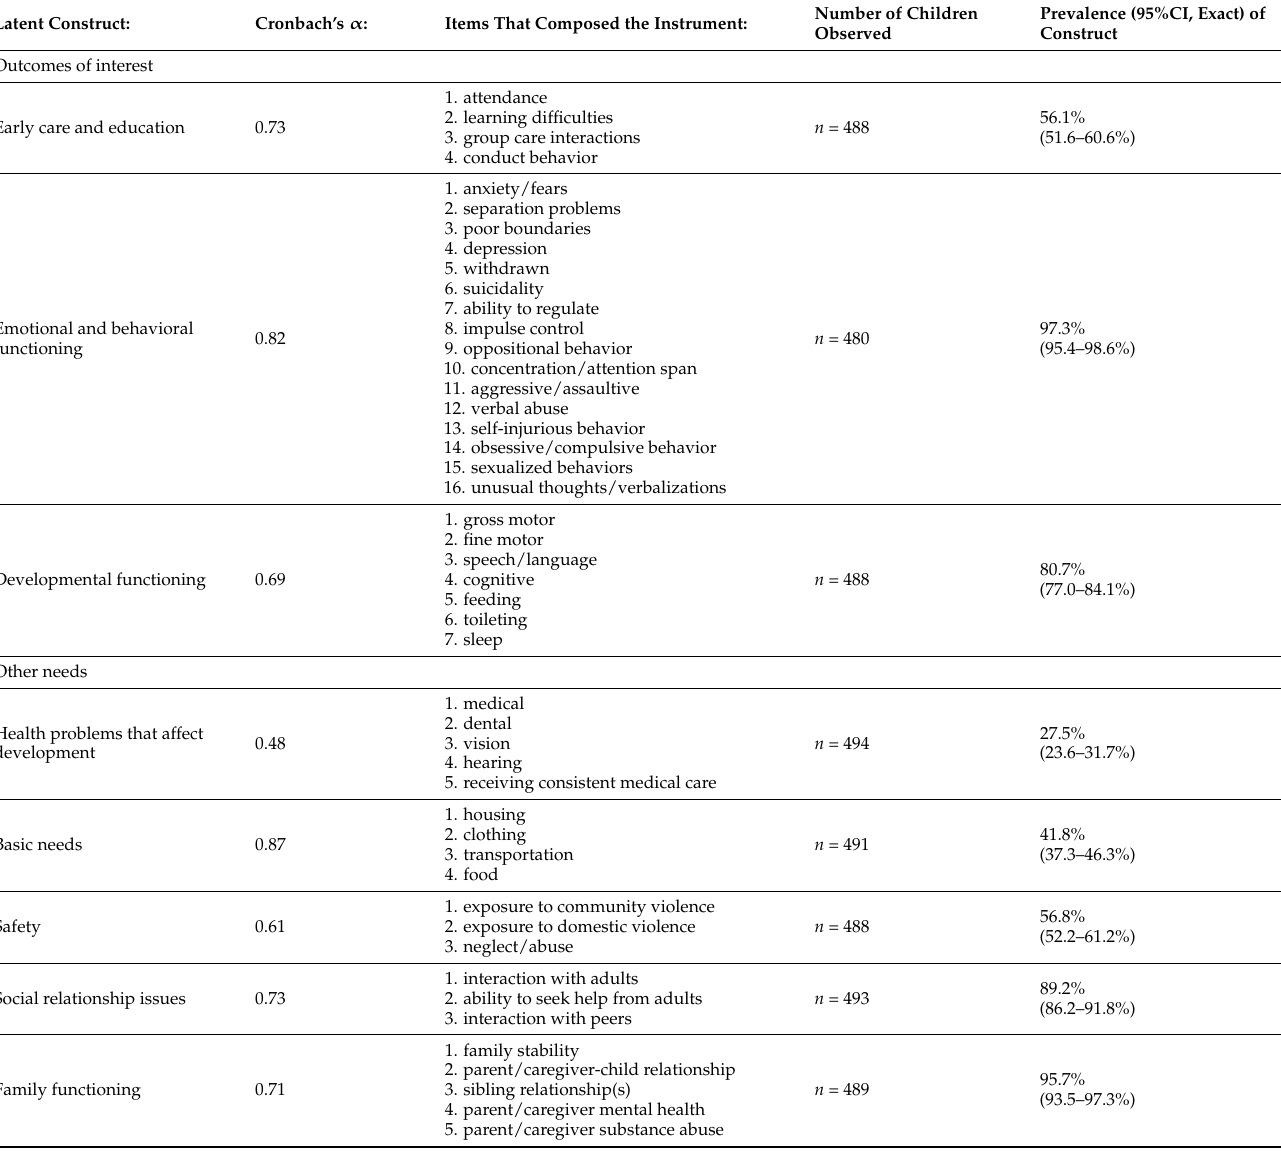
Table 1. Child and family functioning in eight latent construct domains, for children birth-5 at service